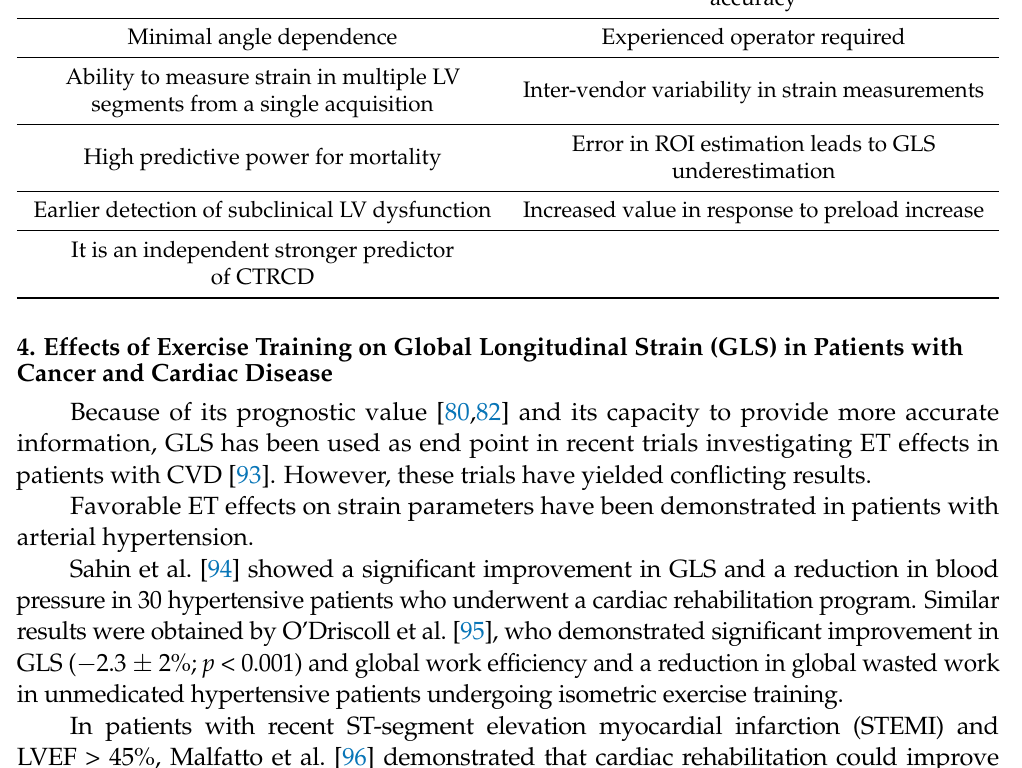
Table 1. Advantages and limitations of GLS. CTRCD: cancer-therapy-related cardiac dysfunction; GLS: global longitudinal strain; LV: left ventricle; ROI: region of interest. Advantages Limitations Cost-effective Not available for all ultrasound devices High reproducibility